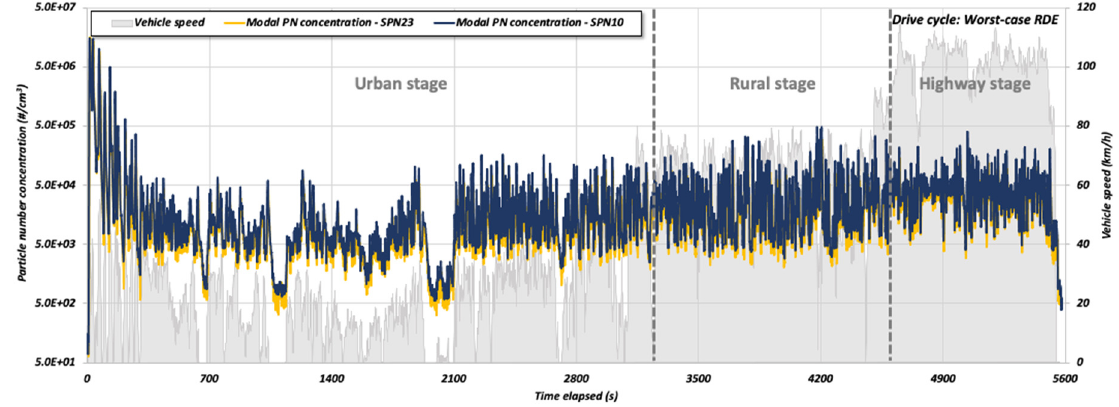
Figure 4. Comparison between SPN23 and SPN10 emissions over a worst-case RDE cycle. Table 4. Distance-based PN results of SPN23 and SPN10 over the laboratory RDE cycle.